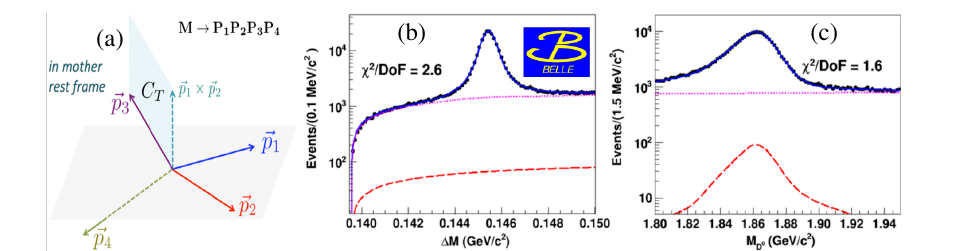
Figure 2. A schematic diagram (a) for the definition of the observable C T = ( p 1 (cid:2) p 2 ) (cid:1) p 3 . The result of simultaneous maximum likelihood fit to the 2D distribution of ∆ M (b), and M D 0 (c) for D 0 with C T >